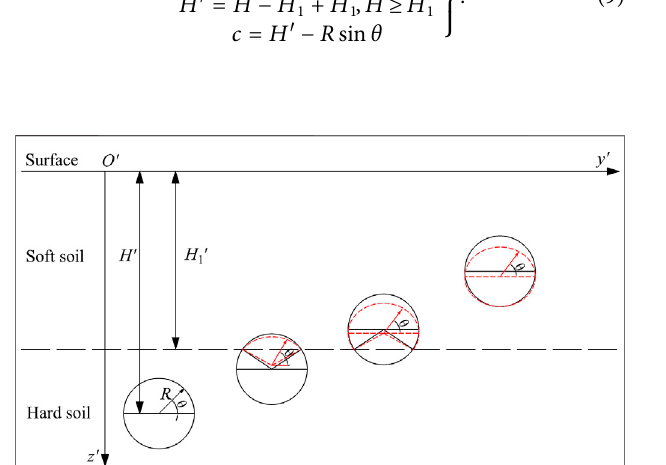
FIGURE 4 | Shield shell friction calculation